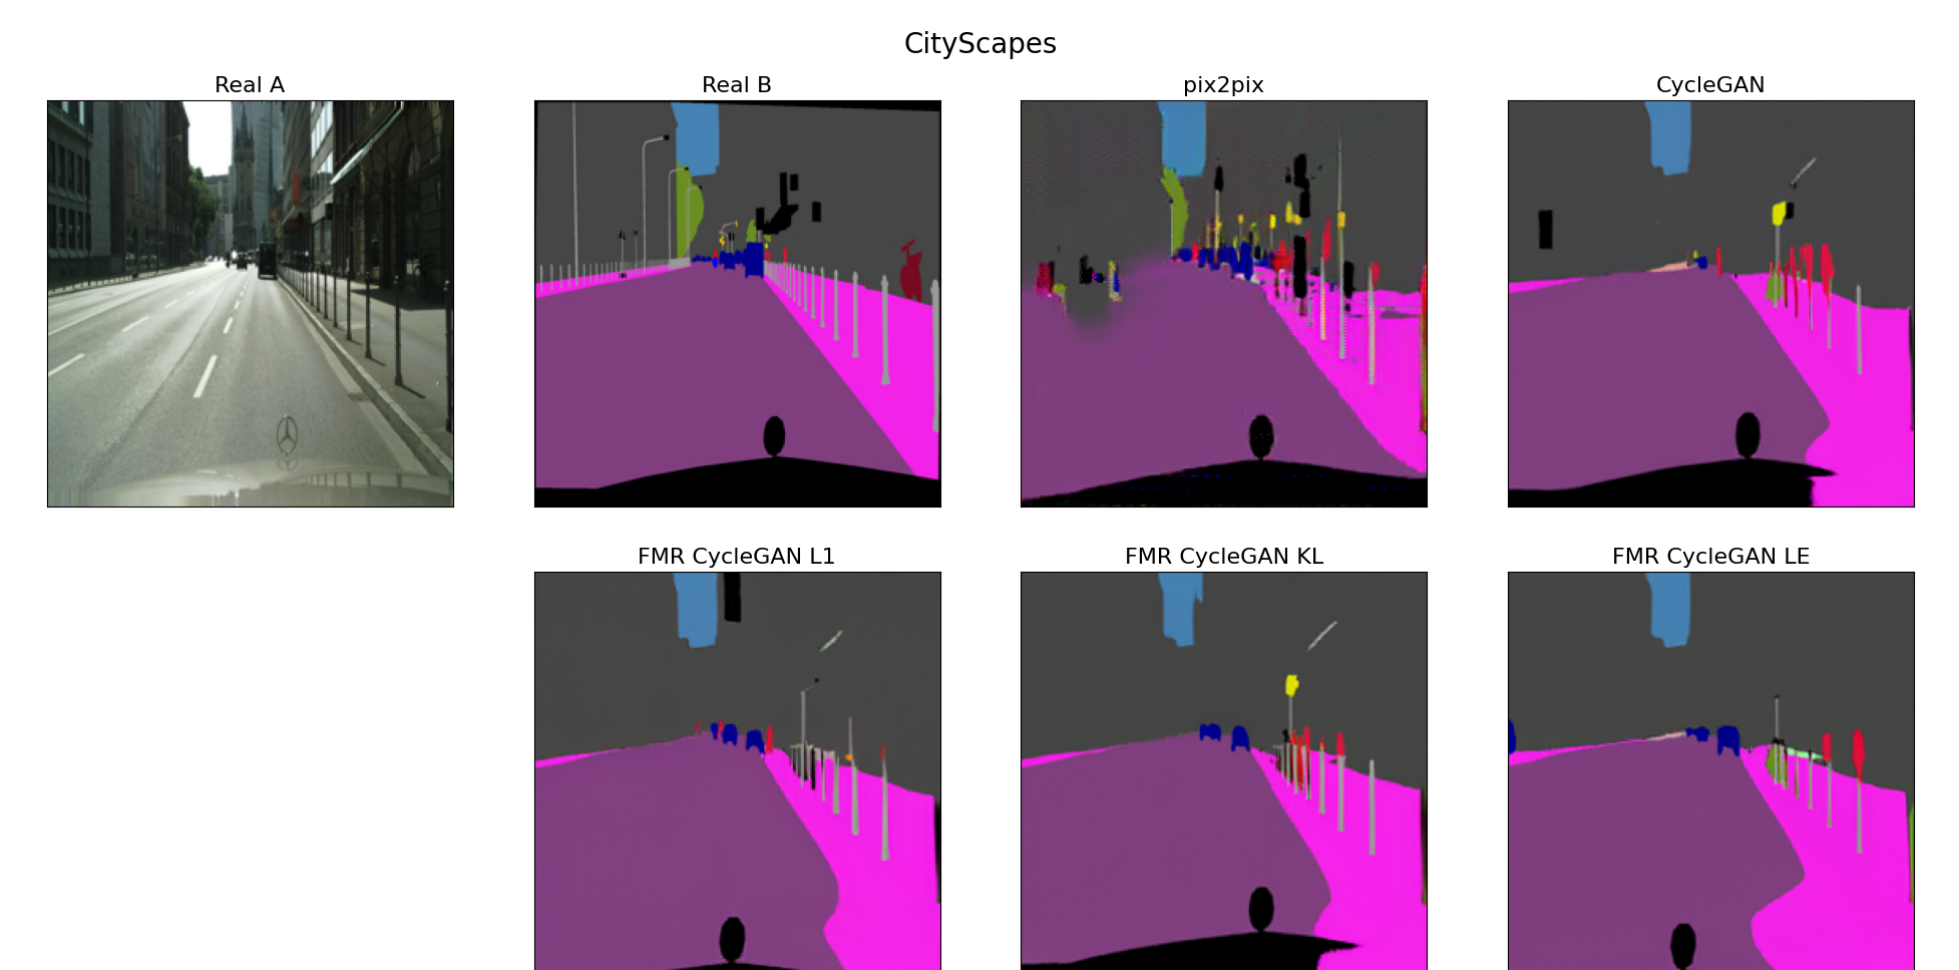
Figure 7. Visual comparison on the second example of paired images from the CityScapes photo2labels task (denoted as “Real A”, belonging to the source or “left” domain, and “Real B”, belonging to the target or “right” domain). The Proposed FMR CycleGAN with various ground distances (L1 corresponding to (8), KL corresponding to (10), and LE corresponding to (12)) was compared against the baseline CycleGAN and pix2pix